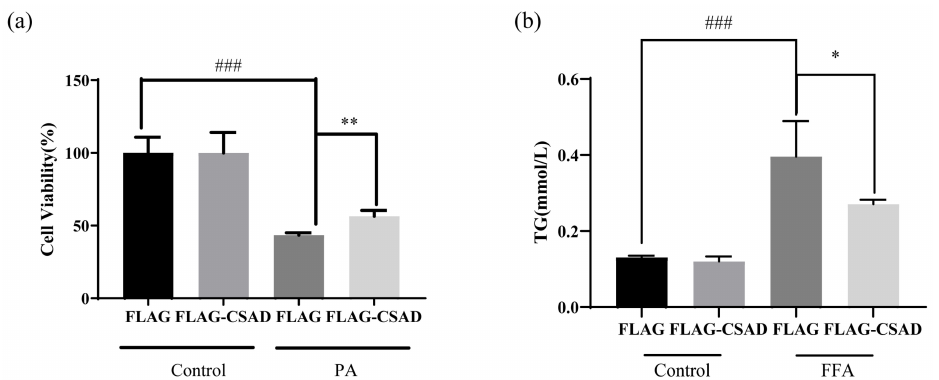
Figure 5. Overexpression of CSAD can ameliorate the decrease in cell viability and lipid accumulation caused by lipotoxicity in HepG2 cells. ( a ) The cell viability of HepG2 cells. After being transfected with FLAG or FLAG-CSAD for 48 h, the HepG2 cells were incubated with or without 0.5 mM PA for 24 h, and the cell viability was detected using the CCK-8 assay; ### p < 0.001 vs. FLAG in the control group; ** p < 0.01 vs. FLAG in PA group. ( b ) The content of TG in HepG2 cells. After being transfected with FLAG or FLAG-CSAD for 48 h, the HepG2 cells were incubated with or without 1mM FFA for 24 h, and the content of serum TG was detected using an enzymatic reagent kit; ### p < 0.001 vs. FLAG in the control group; * p < 0.01 vs. FLAG in FFA group.